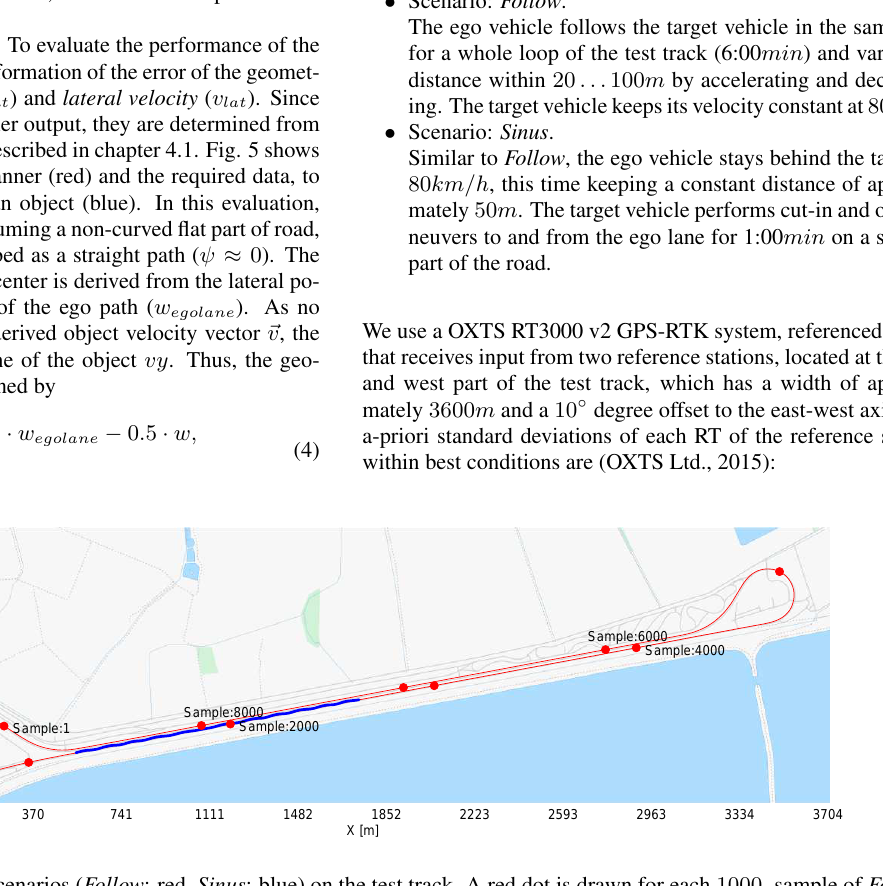
Figure 6: Overview of the scenarios ( Follow : red, Sinus : blue) on the test track. A red dot is drawn for each 1000 . sample of Follow